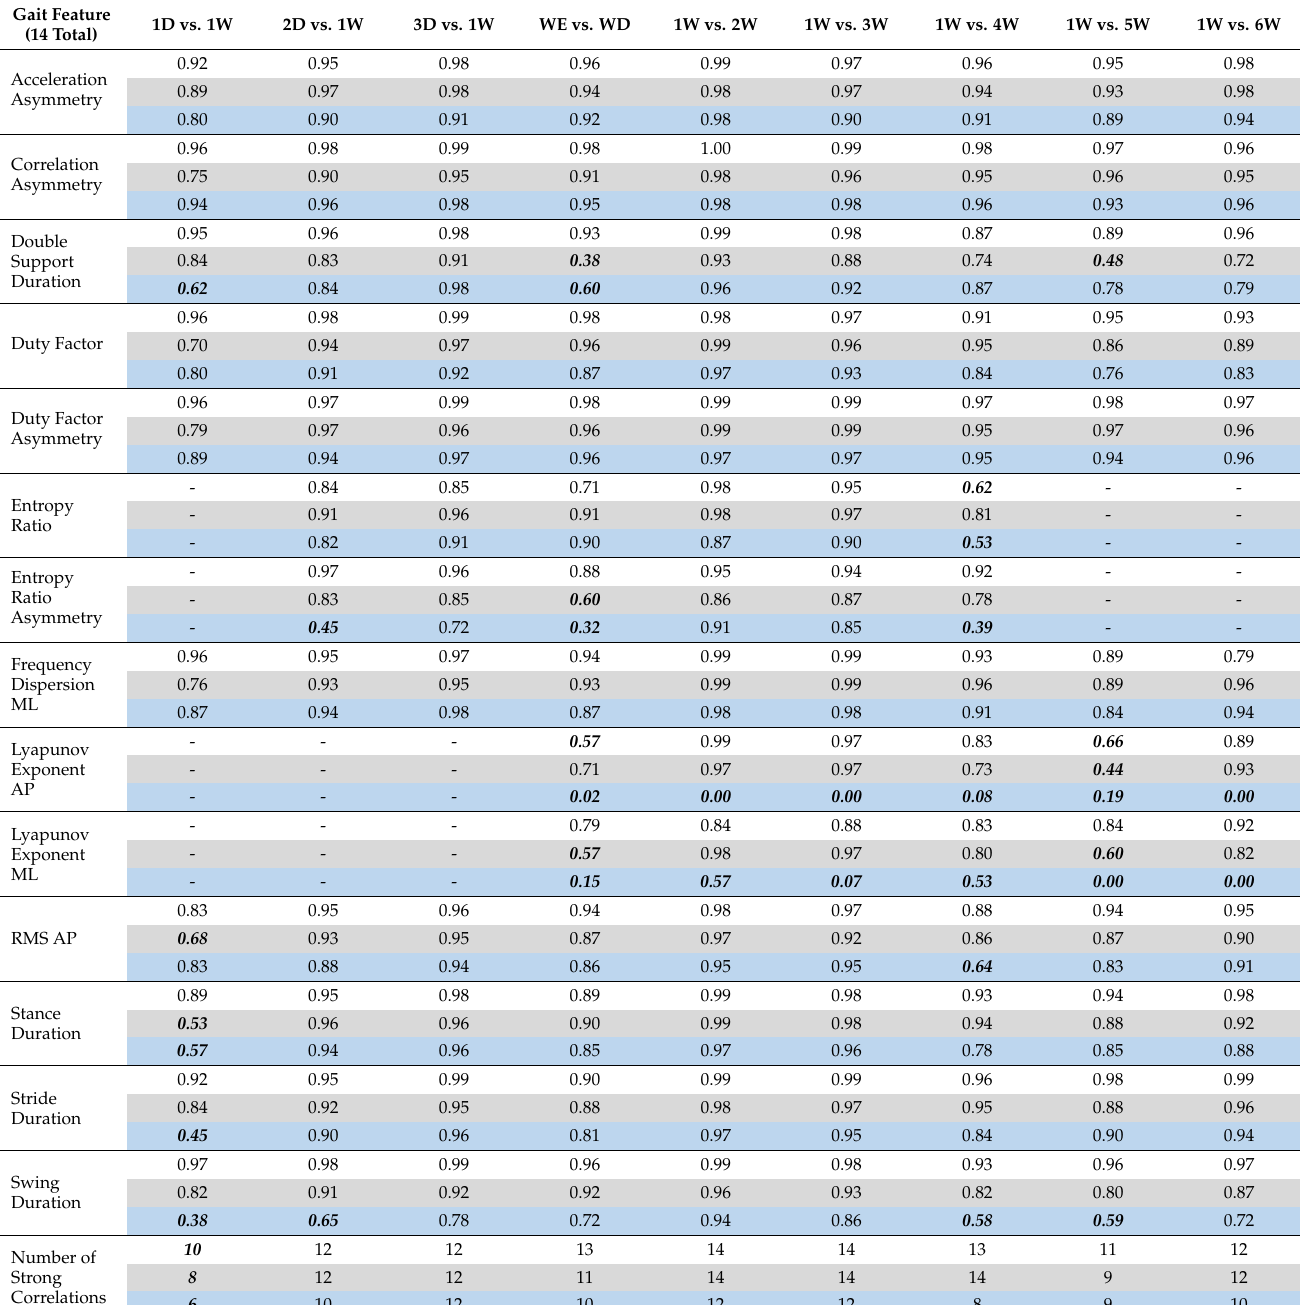
Table A3. Intra-class correlation wear duration gait analysis in persons with